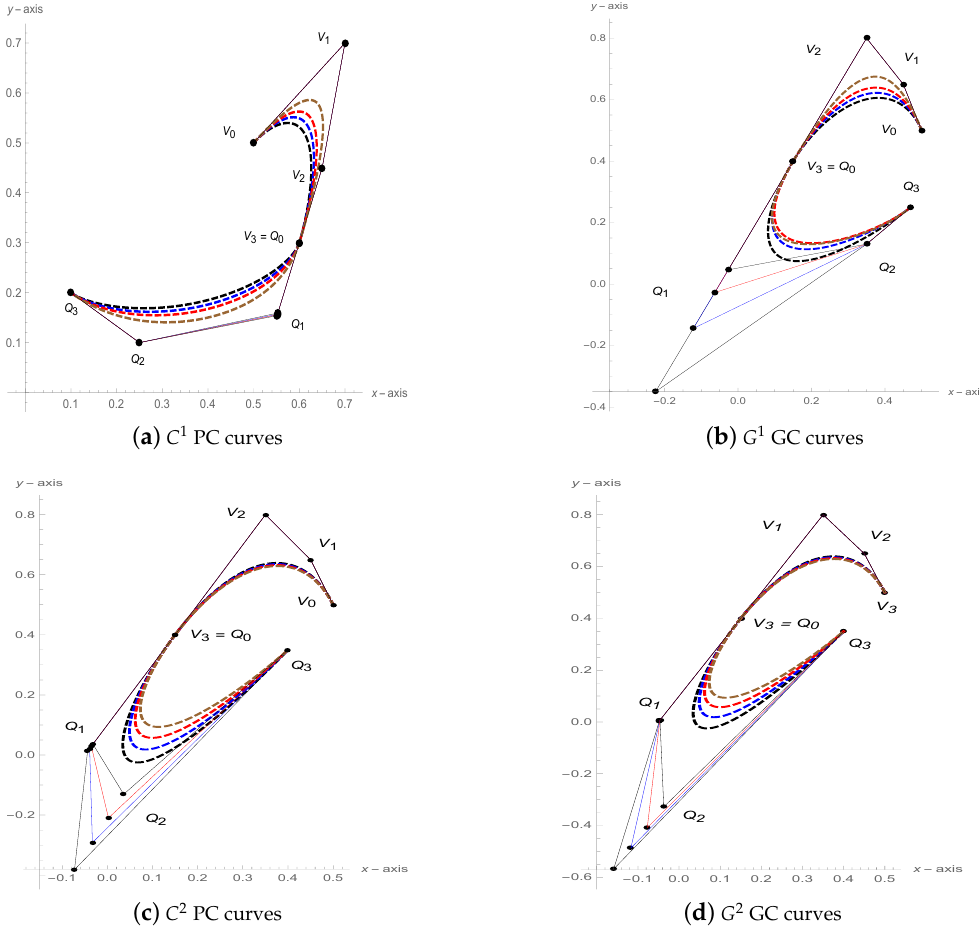
Figure 3. PC and GC curve